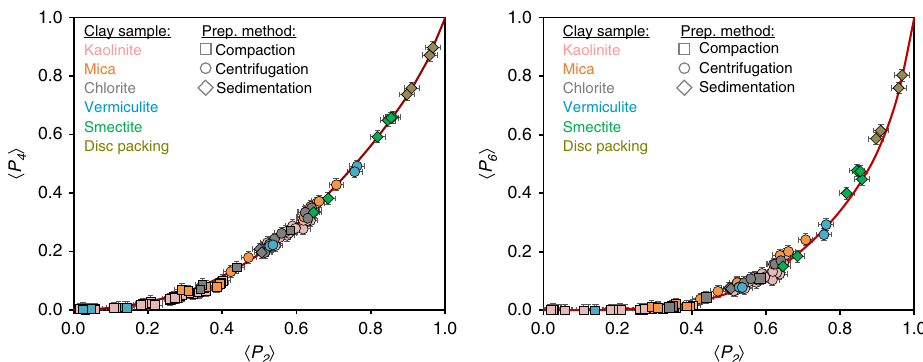
Fig. 4 Determination of the general orientation distribution function for clay minerals. Experimental momenta 〈 P 4 〉 − 〈 P 2 〉 or 〈 P 6 〉 − 〈 P 2 〉 relationships (same notations as Fig. 2) are compared to calculated momenta using the general ODF for clay minerals ( f CM ( θ ) using Eq. (21)) (red line) based on the maximum-